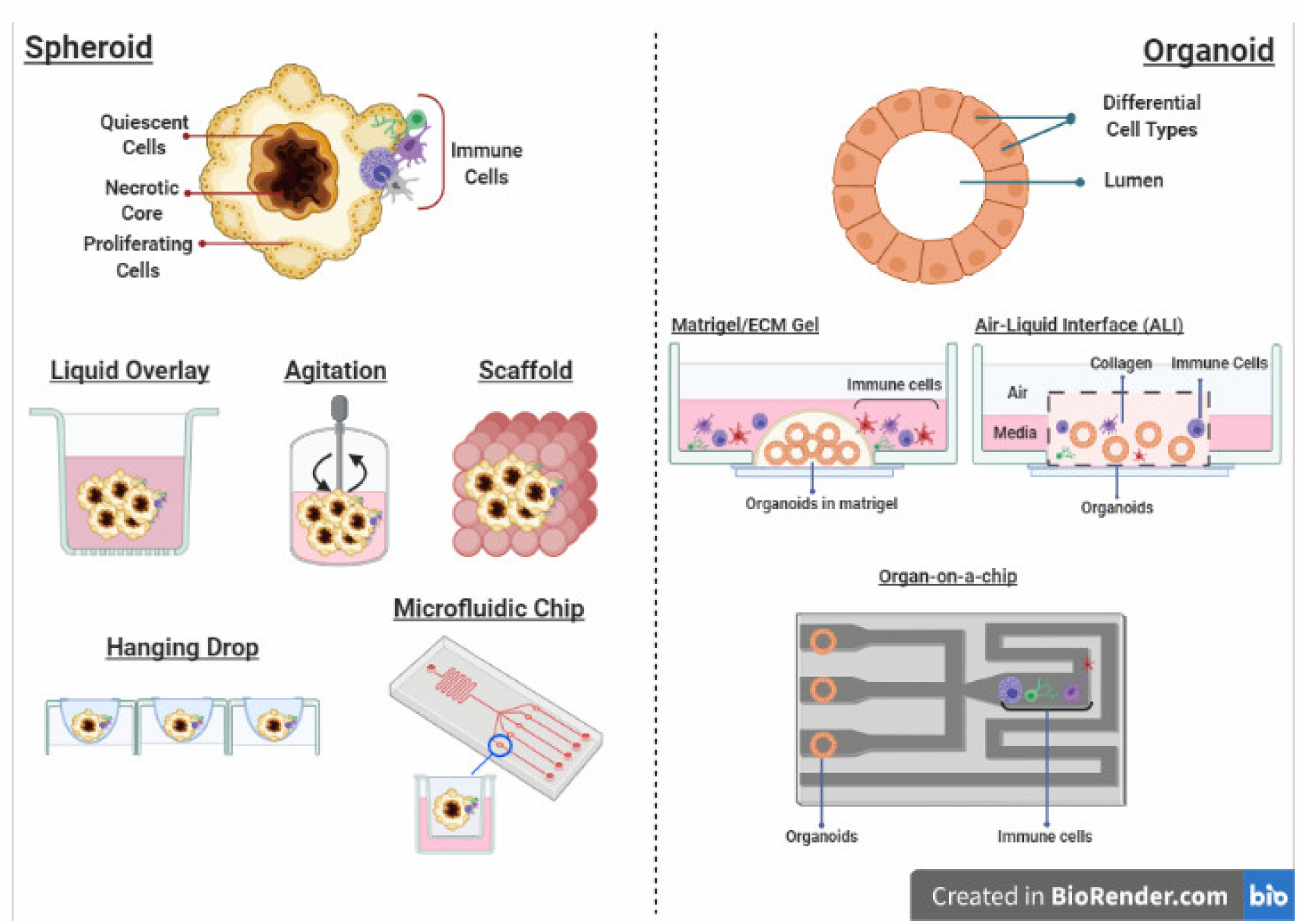
Figure 4. Different culture methods for 3D spheroids and organoids that are compatible with the co-culture of immune cells. Created with BioRender.com (accessed on 6 April